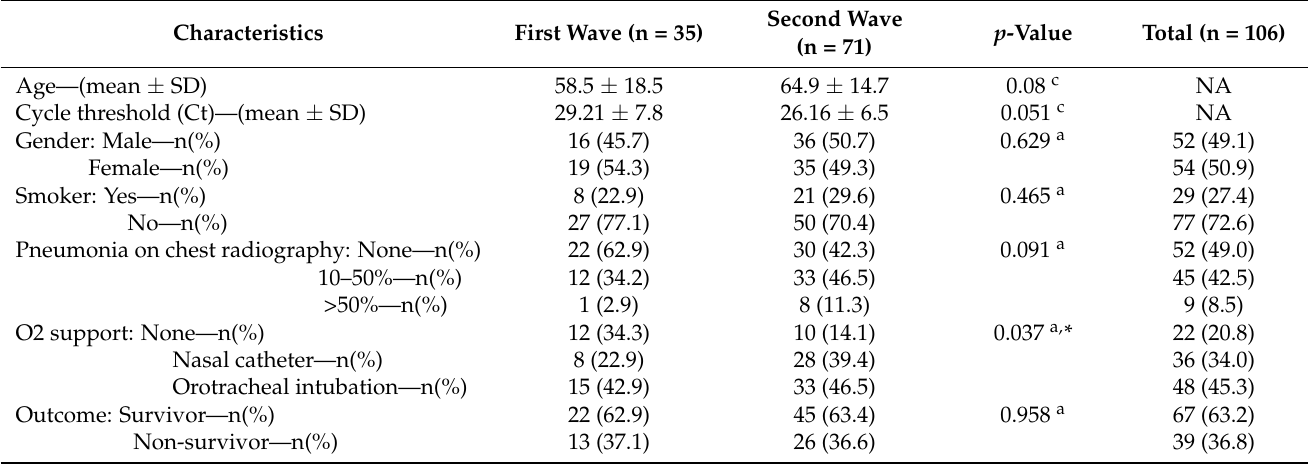
Table 6. Demographic clinical features of COVID-19 according to the first and second